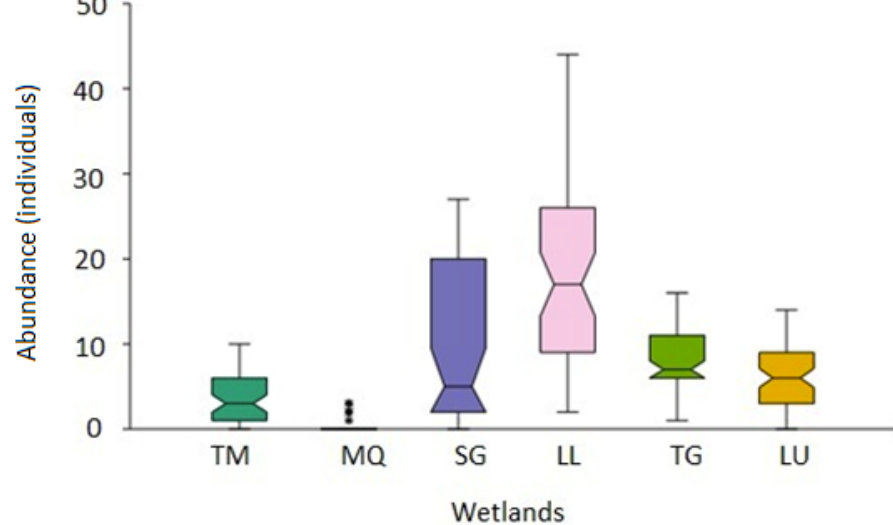
Fig. 2: Abundance of M. marcella larvae in sampled Fig. 2 : Abundance of M. marcella larvae in sampled wetlands.